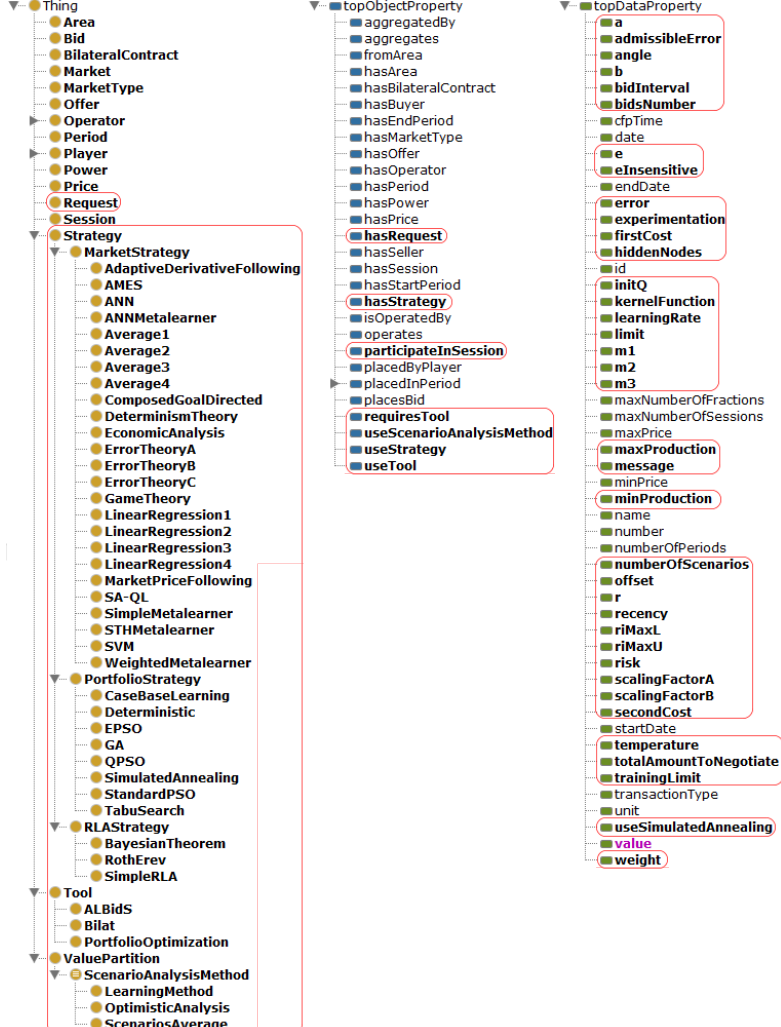
Figure 2. AiD-EM classes, objects, and data